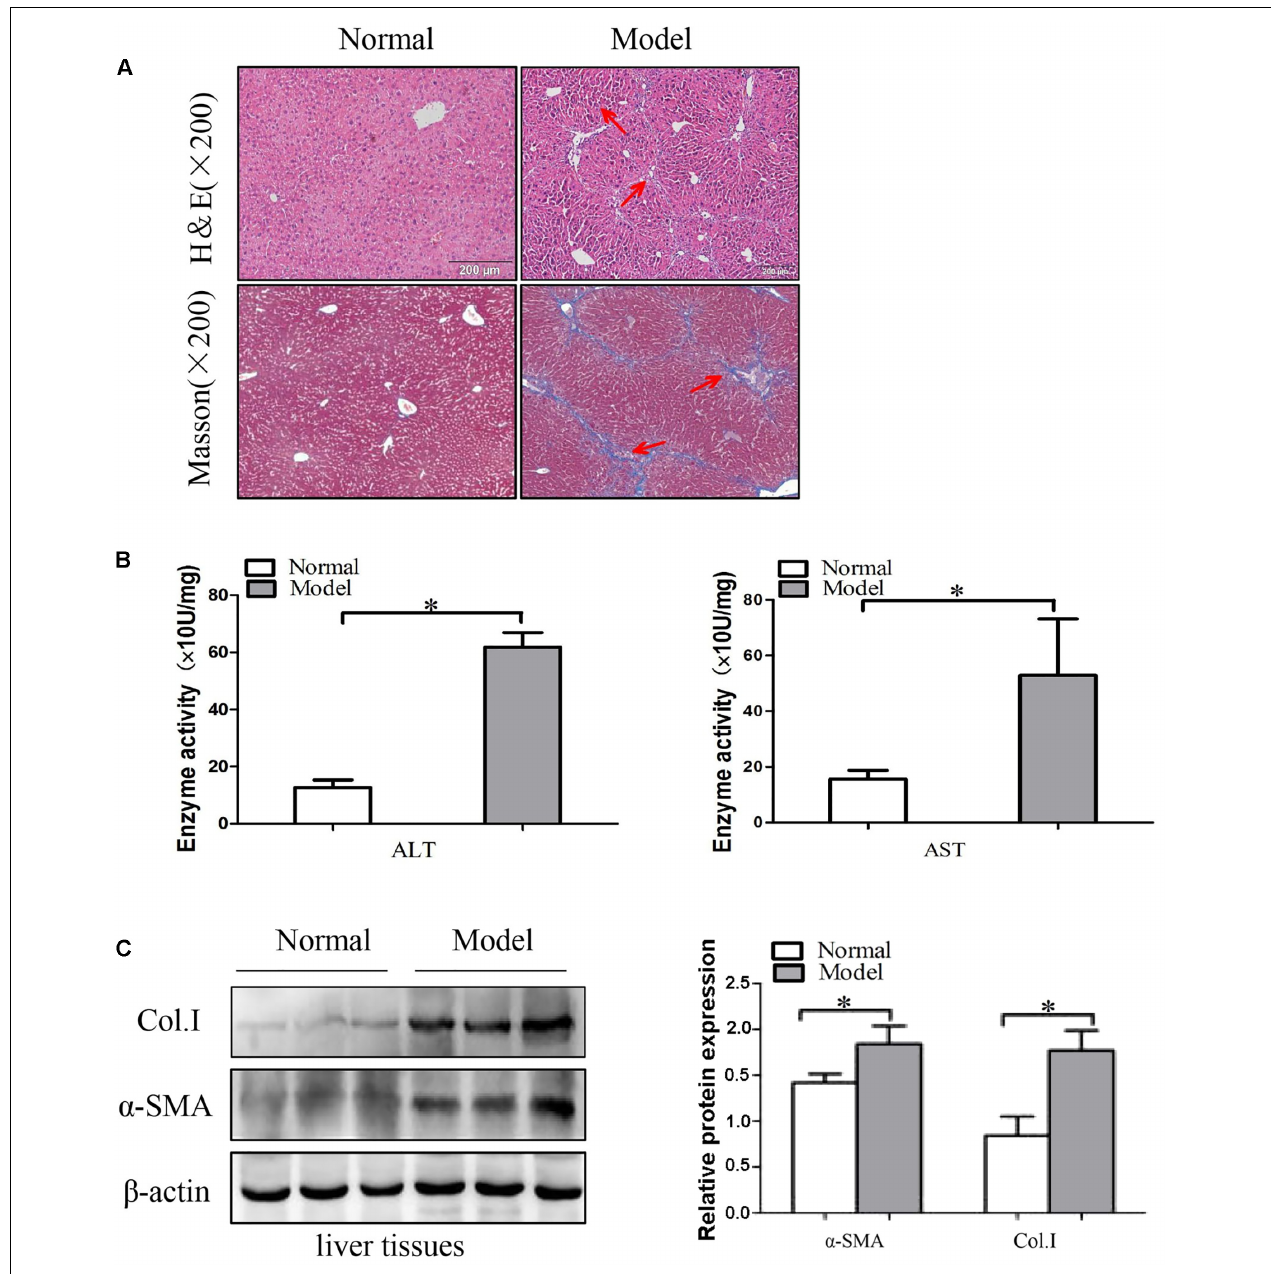
FIGURE 1 | The expression of α -SMA and Col. I during liver fibrosis. (A) Pathological observations of mice liver fibrotic tissues sections and vehicle normal sections, stained with hematoxylin and eosin (H&E) staining ( × 200) and Masson staining ( × 200). Red arrows represent the corresponding pathological changes. (B) Serum level of ALT and AST were measured ( n = 6). (C) Western blot analysis of α -SMA and Col. I with β -actin as the loading control. The assays were performed at least three times with similar results. Data are shown as the mean ± SD ( n = 3) of one representative experiment. ∗ p < 0.05, ∗∗ p < 0.01 versus normal groups.